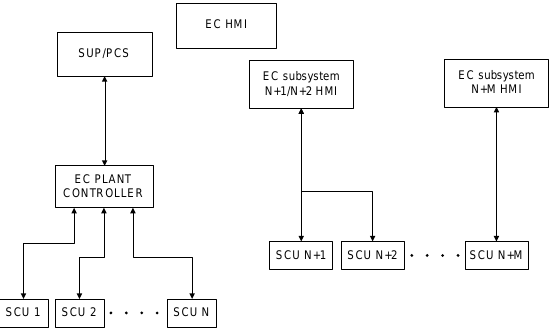
Fig. 8. Subsystems operating with different segregation modes.